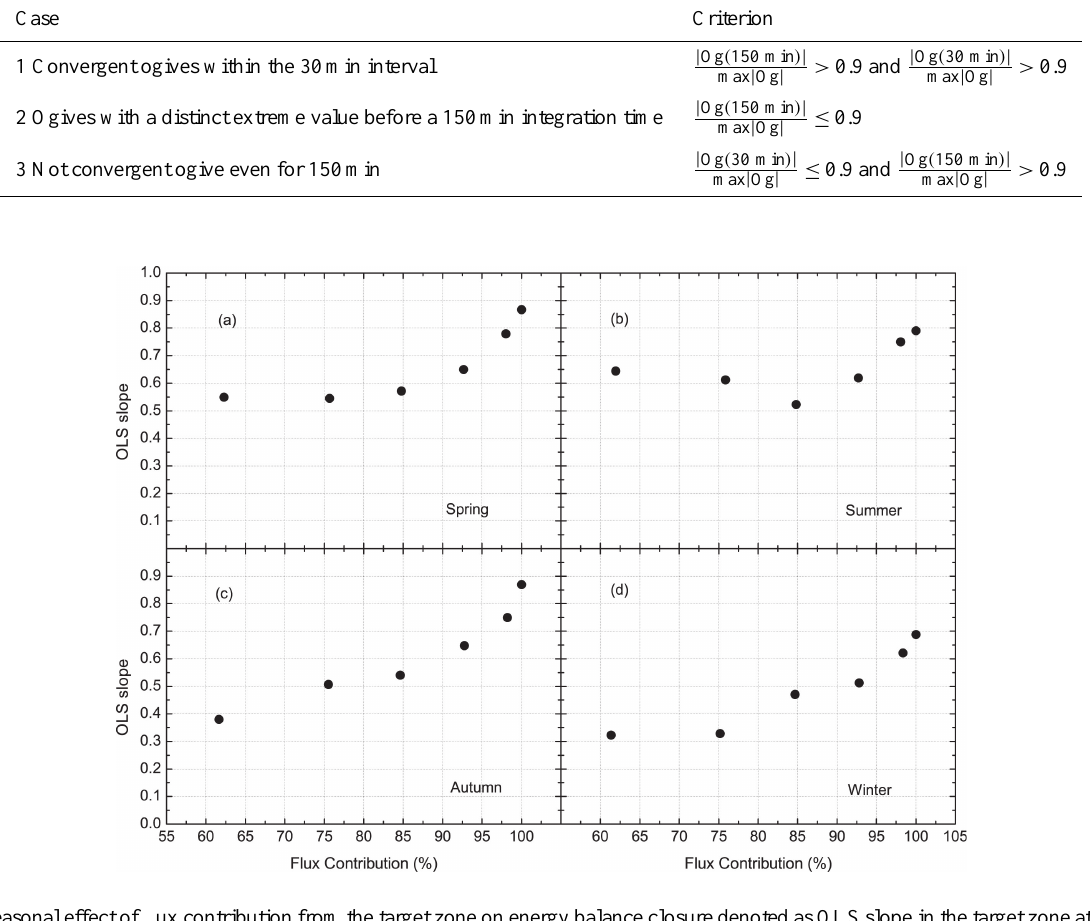
Fig. 9. Seasonal effect of flux contribution from the target zone on energy balance closure denoted as OLS slope in the target zone at SACOL site in (a) spring, (b) summer, (c) autumn, and (d)